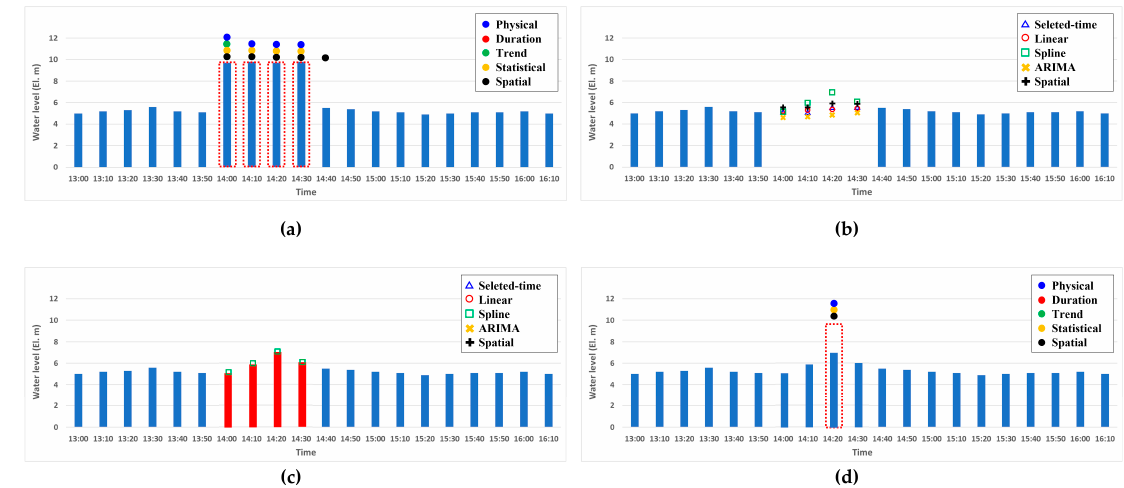
Figure 6. Illustration of iterative quality control process. (a) Data validation of original dataset; (b) Reconstructed values by five reconstruction methods; (c) Data reconstruction chosen by data manager; (d) Data validation of reconstructed dataset.